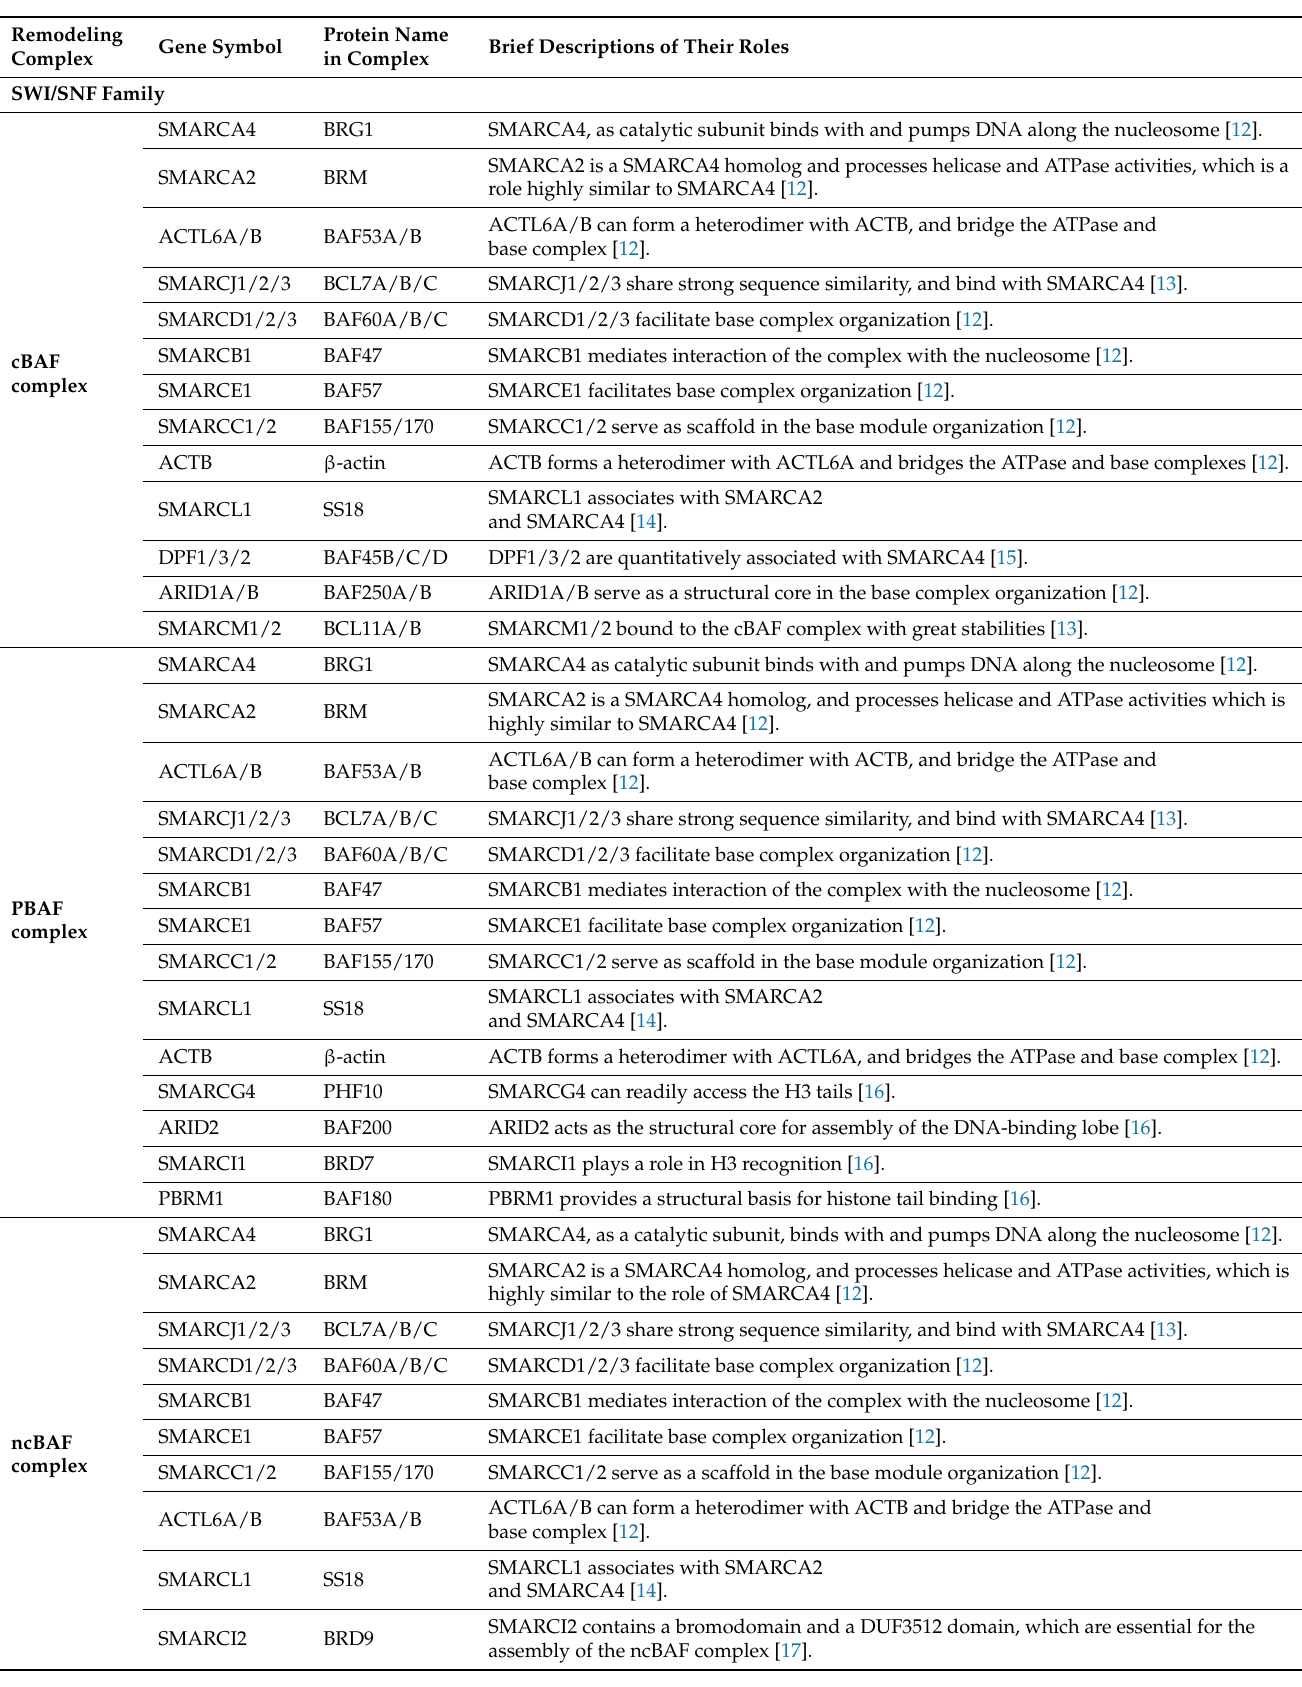
Table 1. Components of chromatin-remodeling